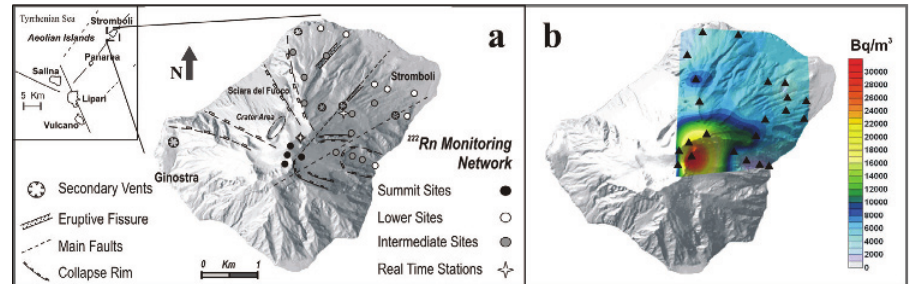
Figure 1: a) Location of the Stromboli volcano in the Southern Tyrrhenian Sea. The main structural features of the island are shown on the topographic DEM. The radon network is divided related to the distance from the active vents. b) The average radon activity on the referred sampling sites obtained by the EPERM R (cid:2) measurements during the period